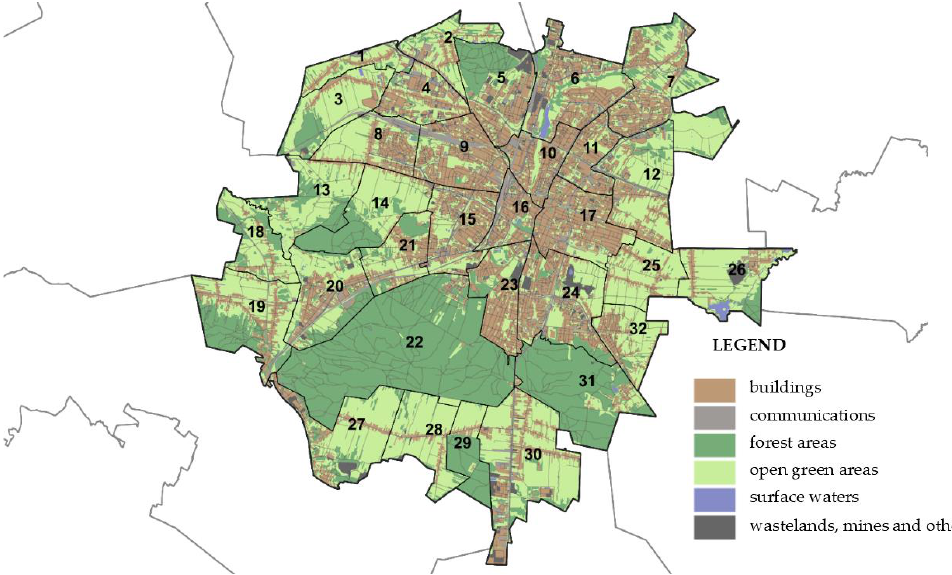
Figure 6. Separate research areas in the city of Kielce.